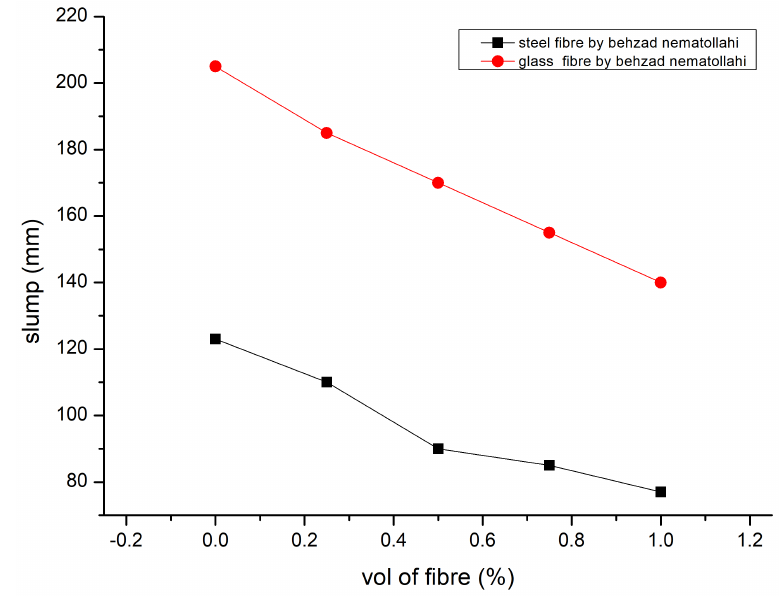
Figure 9. Slump Result [84,107].